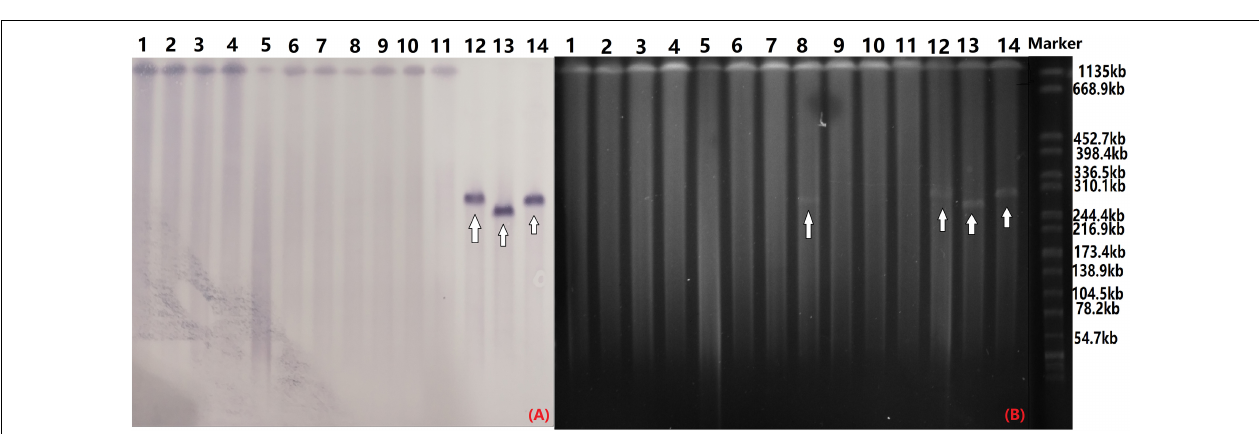
FIGURE 1 | PFGE fingerprinting patterns and other characteristics of Salmonella isolates harboring bla CTX - M - 55 genes.